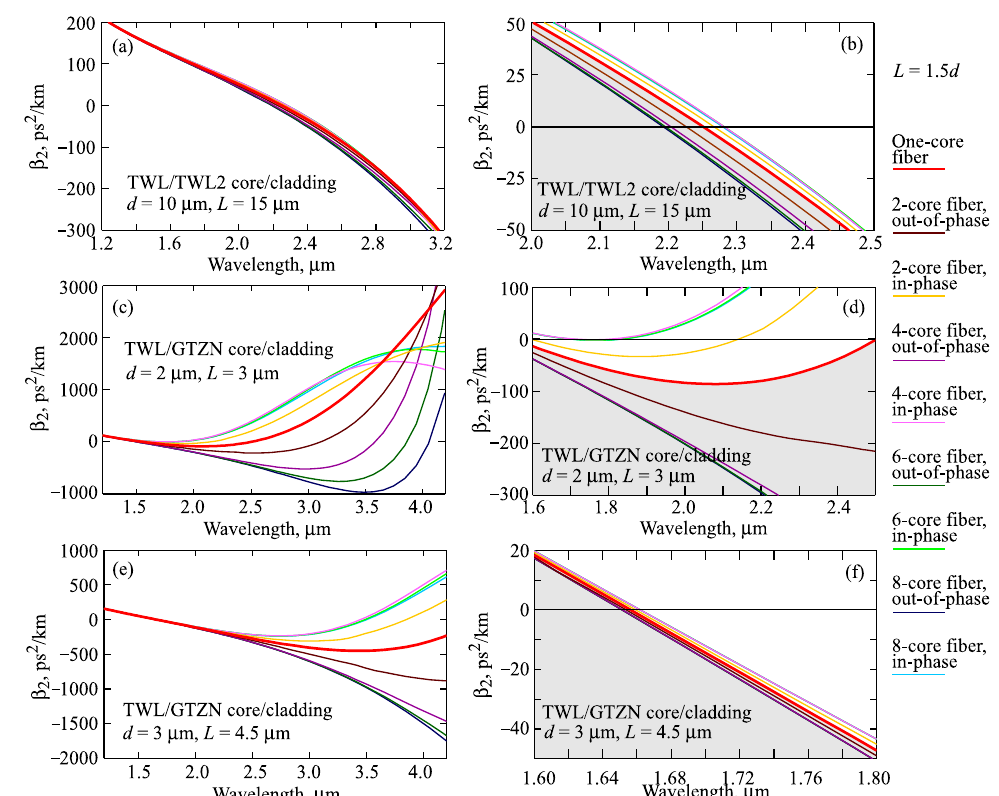
Figure 6. The calculated dispersion in wide wavelength ranges (left column) and at magnified scales near ZDWs (right columns) for fibers with a different number of cores with L = 1.5 d for TWL/TWL2 core/cladding with d = 10 μm ( a , b ); for TWL/GTZN core/cladding with d = 2 μm ( c , d ); and for TWL/GTZN core/cladding with d = 3 μm ( e , f ). In the right column, the dispersion curves for out-of-phase supermodes are located in the gray areas under the dispersion curves for one-core fibers.